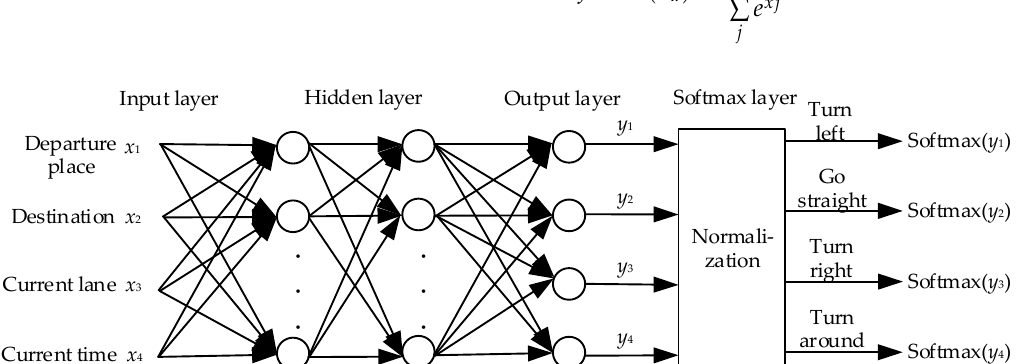
Figure 4. The structure of the neural network.